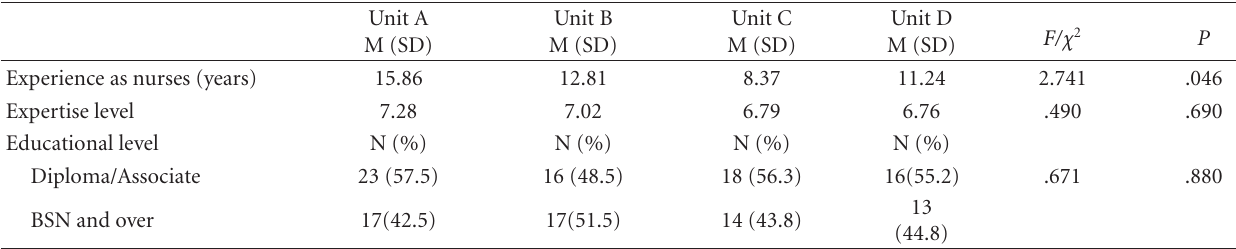
Table 1: Homogeneity test by unit characteristics ( n =